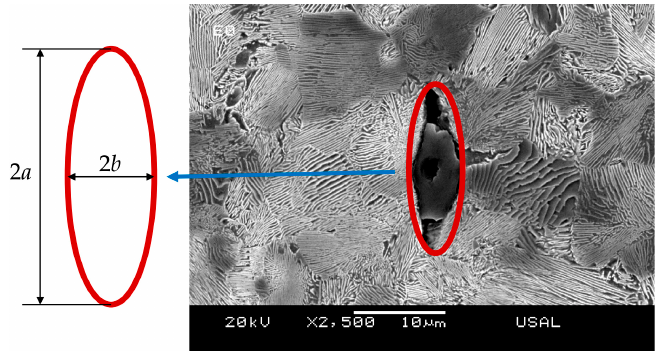
Figure 7. Approximation of the inclusion and its microcavity to an ellipse.